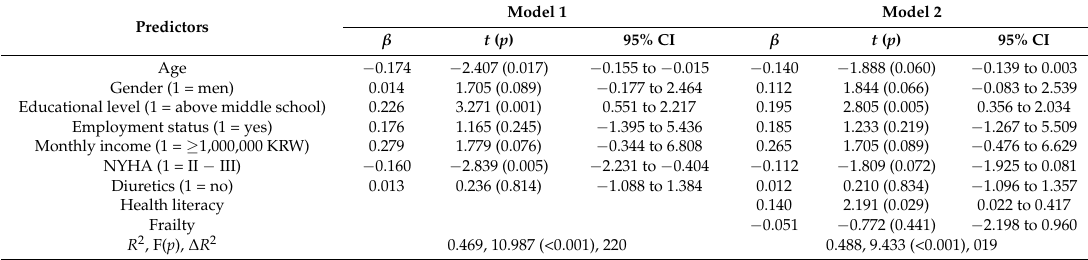
Table 4. Hierarchical regression analysis for health literacy and frailty as determinants of self-care ( n =